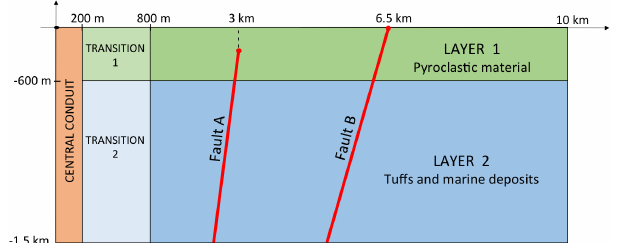
Figure 2. Heterogeneous hydrological domain. Two transition zones are placed between the central conduit and Layers A and B, with intermediate hydrological parameters (Table 1). Atmospheric boundary conditions are fixed on the top (which is open to fluid and heat flow), lateral boundaries are assumed to be impervious and adiabatic, while a heat flux is assigned at the bottom impervious boundary at a rate of 0.195Wm − 2 to ensure a temperature gradi- ent comparable to that estimated for CF ( ∼ 130 ◦ Ckm − 1 , (Rosi and Sbrana, 1987; De Siena et al., 2010; Piochi et al., 2014)).